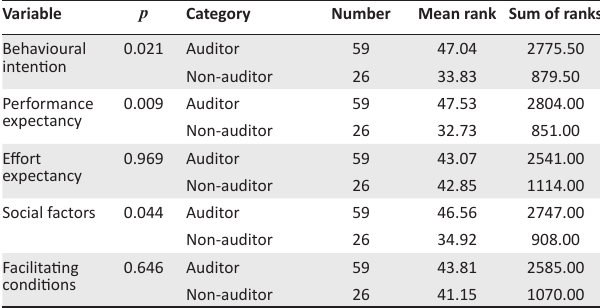
TABLE 2: Mann-Whitney U-Test.